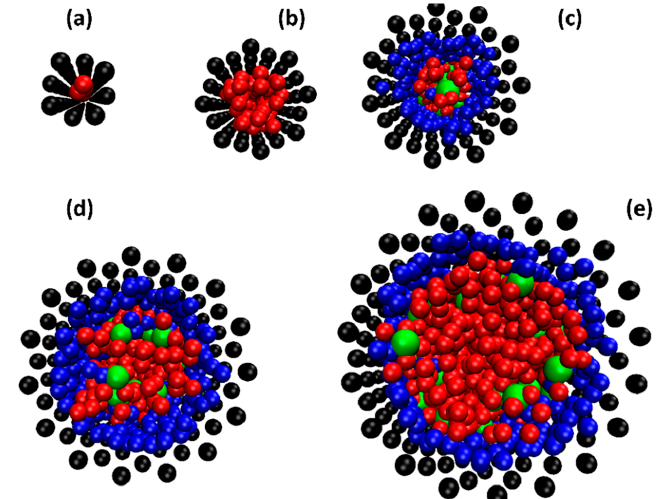
Figure 3. The equilibrium snapshot (top view) of SDS and water beads inside an (8, 8) ( a ); a (15, 15) ( b ); a (22, 22) ( c ); a (30, 30) ( d ); and a (37, 37) ( e ) SWCNT at 298K with total SDS concentration of 3 wt %. For SDS molecules, head and tail groups are shown in green and blue beads. CNT and water are in black and red beads, respectively. Note that the surfactant adsorption outside the CNT is removed for clarity.